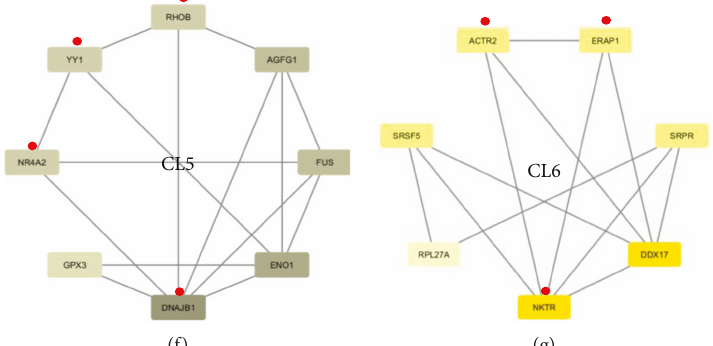
Figure 5: Network analysis of genes modulated in Behçet ’ s disease. (a) PPI network of di ff erentially expressed genes in BD. (b – g) Graphical representation of the six clusters that were extracted from the PPI network of modulated genes in BD. Red dots indicate DEGs that are targeted by modulated miRNAs in